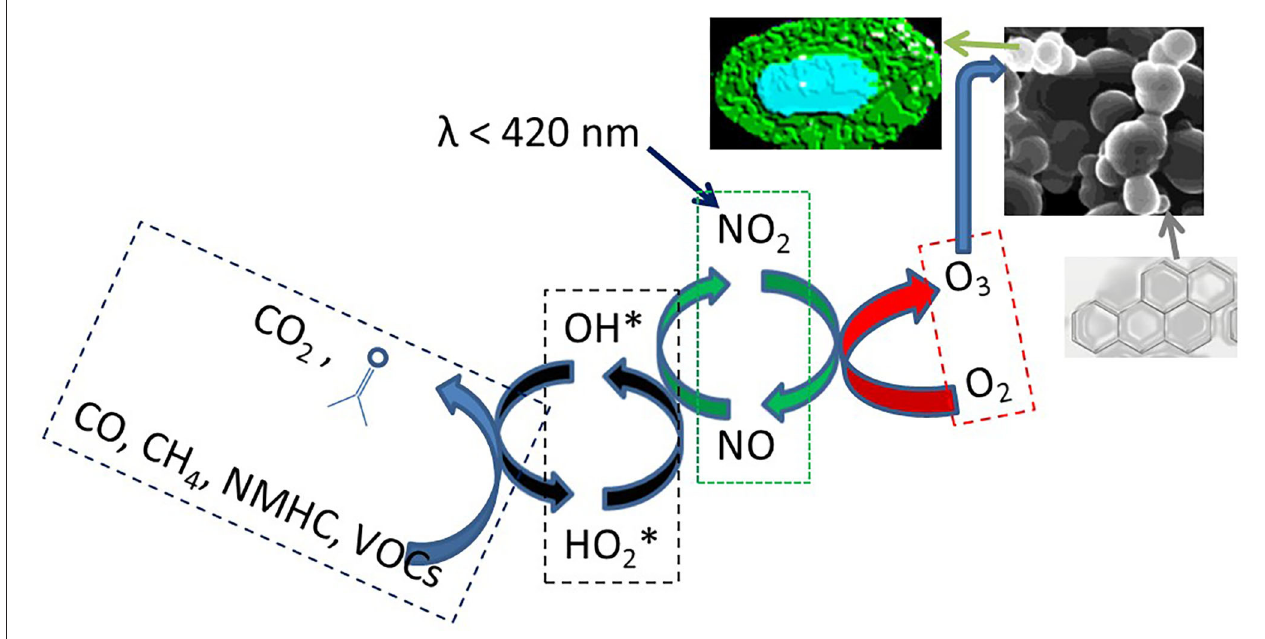
FIGURE 1 | A cartoon mimicking tropospheric coupled system of HO x and NO x cycle involving the oxidation of CO/NMHCs/VOCs/CH 4 and forming O 3 that further oxidizes SB-PAHs (and other organics) plausibly leading to the formation of CCN (cloud condensation nuclei).